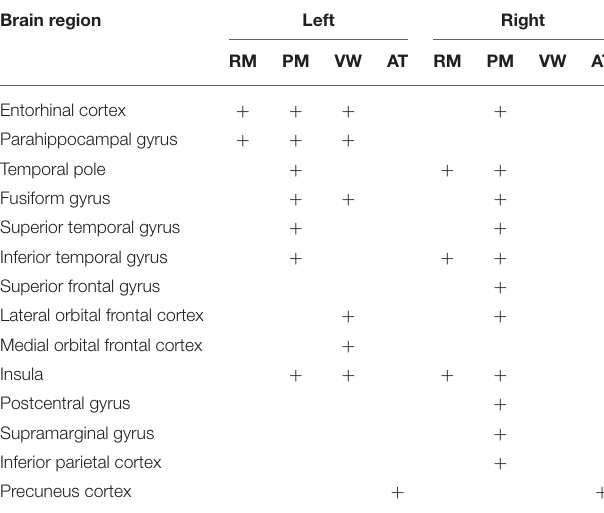
TABLE 5 | Cortical thickness correlated with each factor score. Brain region Left Right